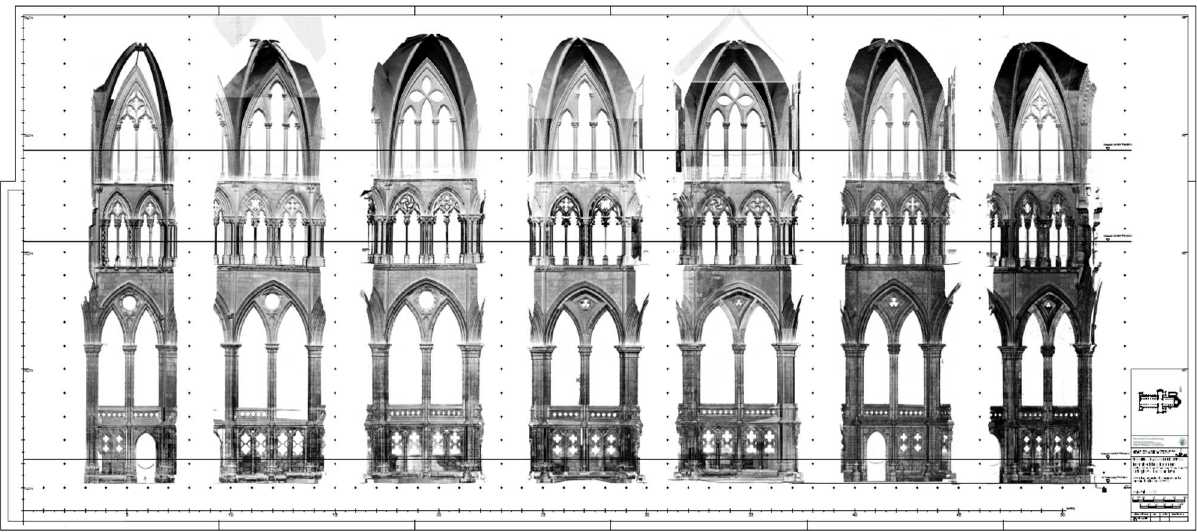
Figure 3. Inner elevation development of the bays NW, N, NO, O, SO, S, SW, except western Screen Wall (clockwise).